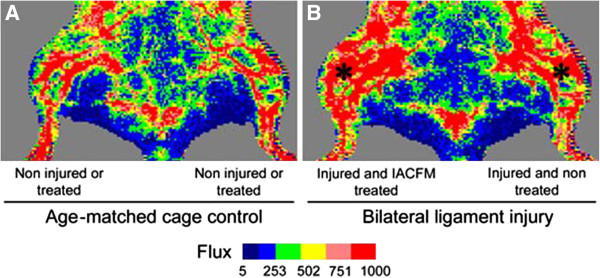
Representative laser Doppler images for the left and right hindlimbs in A: aged-matched uninjured control animal and B: animal with bilateral knee MCL injuries (*) at four weeks post-injury. A: Tissue flux (perfusion) was equivalent in the right and left legs of age-matched control animals, animals prior to surgically-induced MCL injury, and animals immediately prior to the initial IACFM treatment (i.e. one week following MCL injury). B: Tissue flux (perfusion) was increased in the IACFM treated hindlimb at 4 weeks following injury and 1 week following the final IACFM treatment, compared to the contralateral non-treated injured hindlimb.